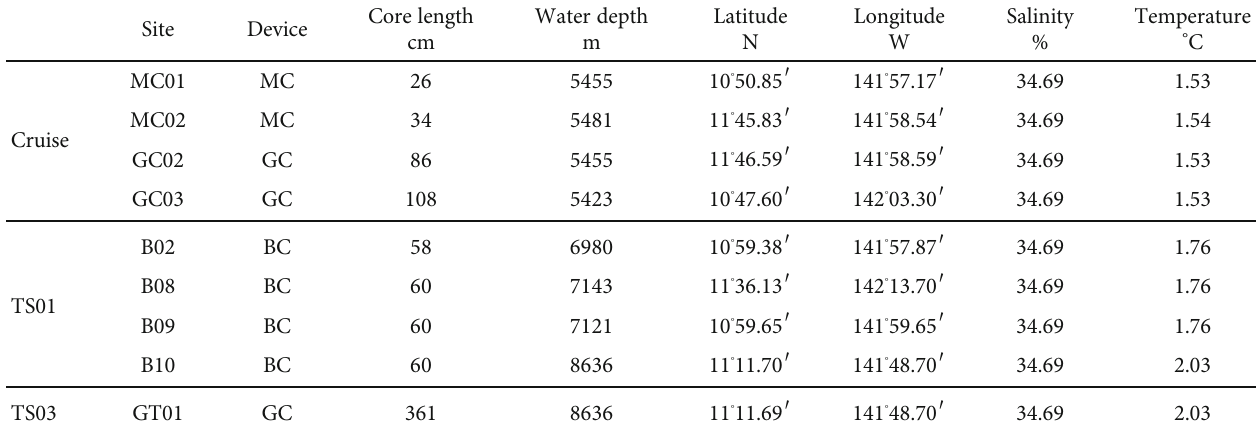
Table 1: The basic information of sediment